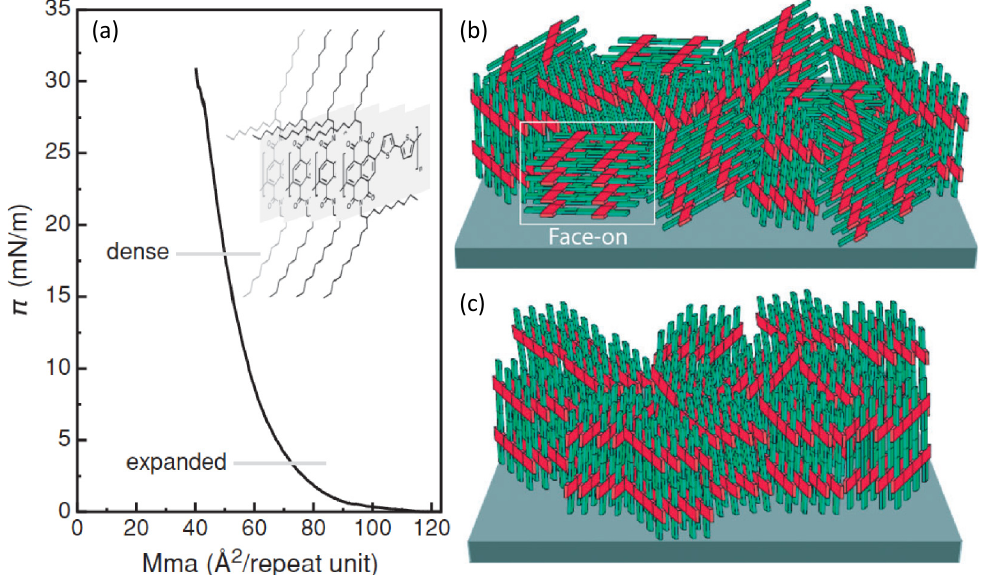
Figure 5. ( a ) Superficial pressure vs. mean molecular area graph showing the rise in pressure as the polymer self-assembly proceeds toward the edge-on packing. (Reprinted with permission from Reference [69]. Copyright (2012) by the Wiley-VCH Verlag GmbH & Co.); ( b,c ) Descriptive depictions respectively of a mixed face-on/edge-on structure and of a strictly packed edge-on structure (Reprinted with permission from Reference